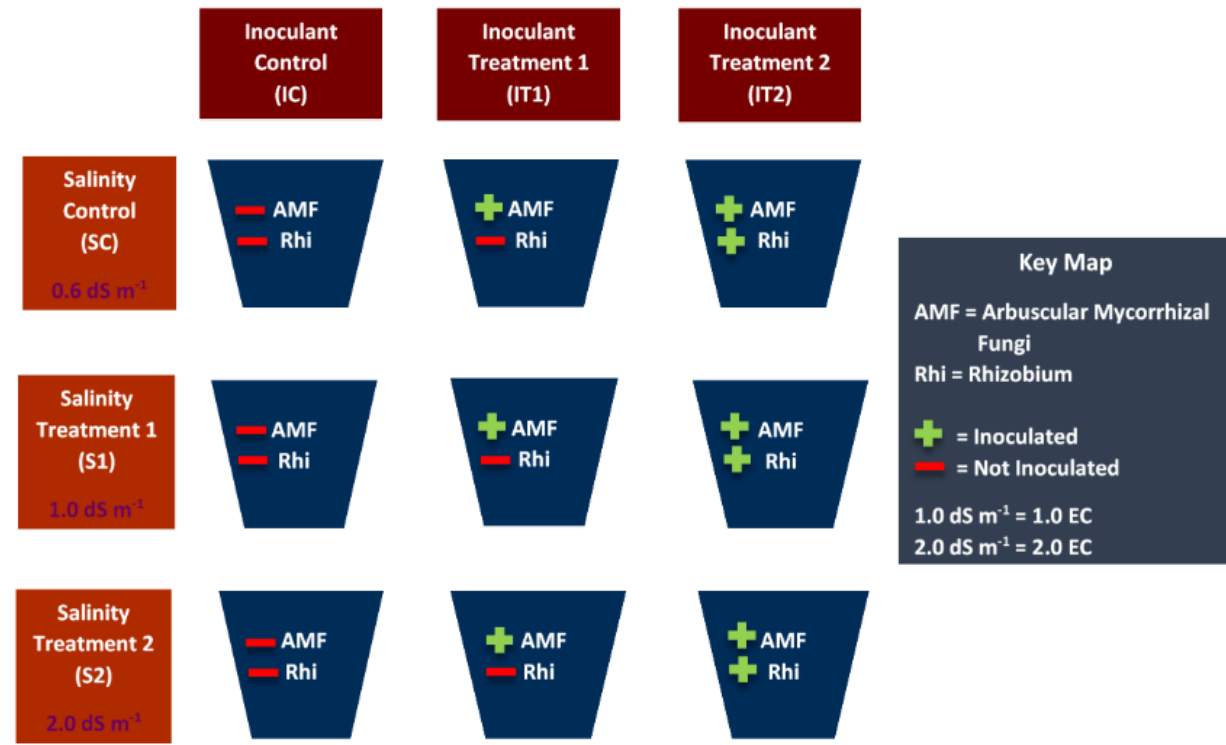
Figure 1. Experimental layout (3 × 3 factorial) for the shade house experiment, including different salinity treatments (control or salinity control (SC), treatment 1 or S1, and treatment 2 or S2) and inoculation treatments (control or inoculation control (IC,) treatment 1 or IT1, and treatment 2 or IT2). Two inoculants used for this study were arbuscular mycorrhizal fungi (AMF) and Rhizobium (Rhi), with + and − signs indicate inoculated and not inoculated, respectively. Each treatment had 10 replications.